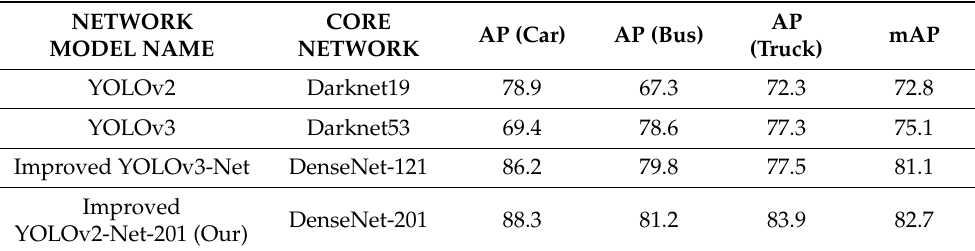
Table 6. Comparison of Proposed Networks with existing models on Pascal VOC Dataset.